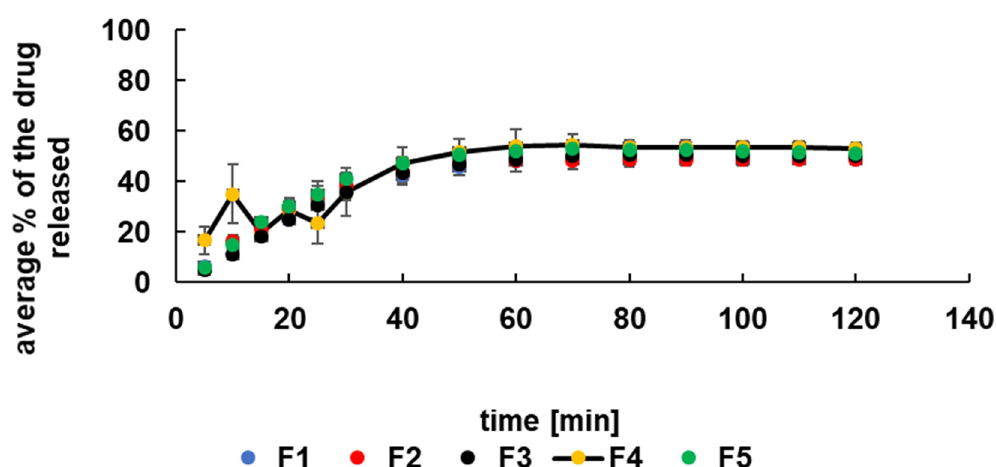
Figure 4. The release profiles of 5-ASA from F1–F5 in pH = 1.0 buffer.